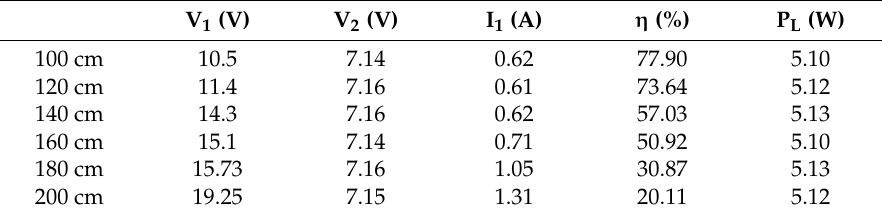
Table 4. Measured power results of the WPT system with the MMs.